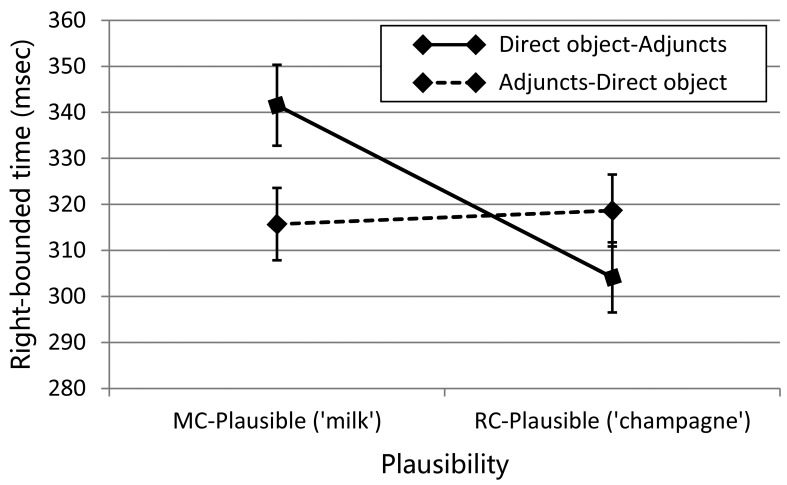
Right-bounded times in the critical region.Error bars show by-participants standard errors.